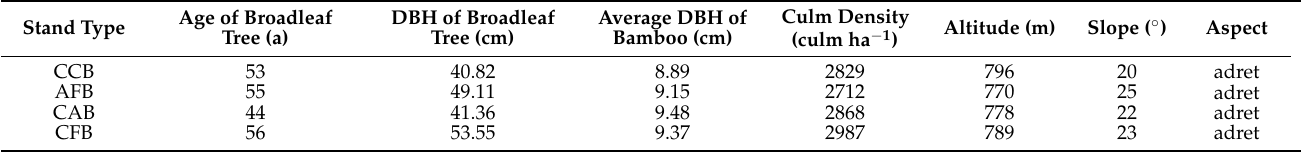
Table 1. Stand characteristics of bamboo–broadleaf mixed